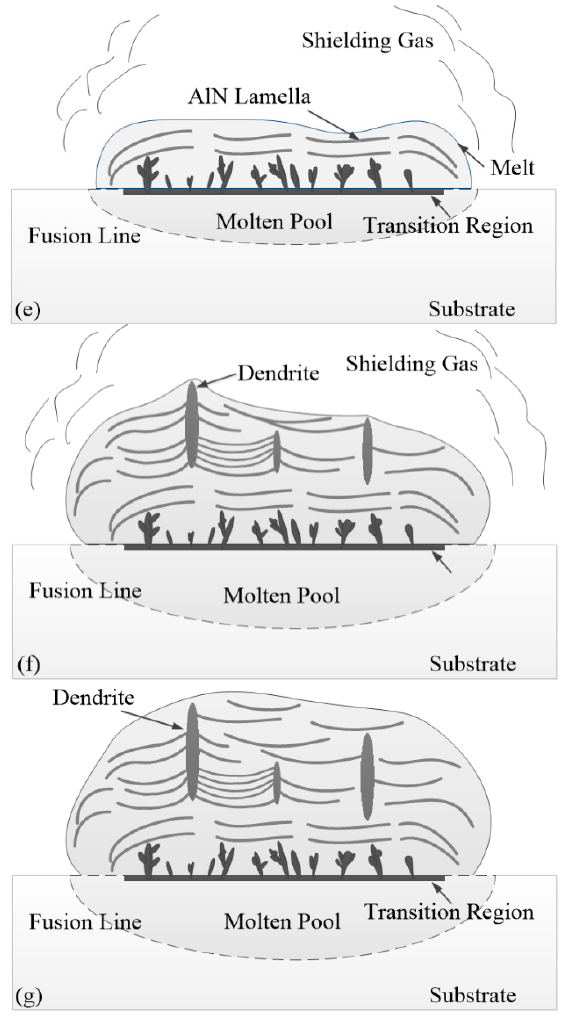
Figure 9. Formation stages of the nitrided layer. ( a ) The locations of each stage. ( b ) The formation of the transition region. ( c ) The partial enlargement of (a) on different substrates. ( d ) The formation of the dendrite region. ( e ) The formation of lamellae in the lamella region. ( f ) The transformation between lamellae and dendrite-like structures in the lamella region. ( g ) The final structure of the nitrided layer. As the nitriding process goes on and the temperature increases, the molten pool extends